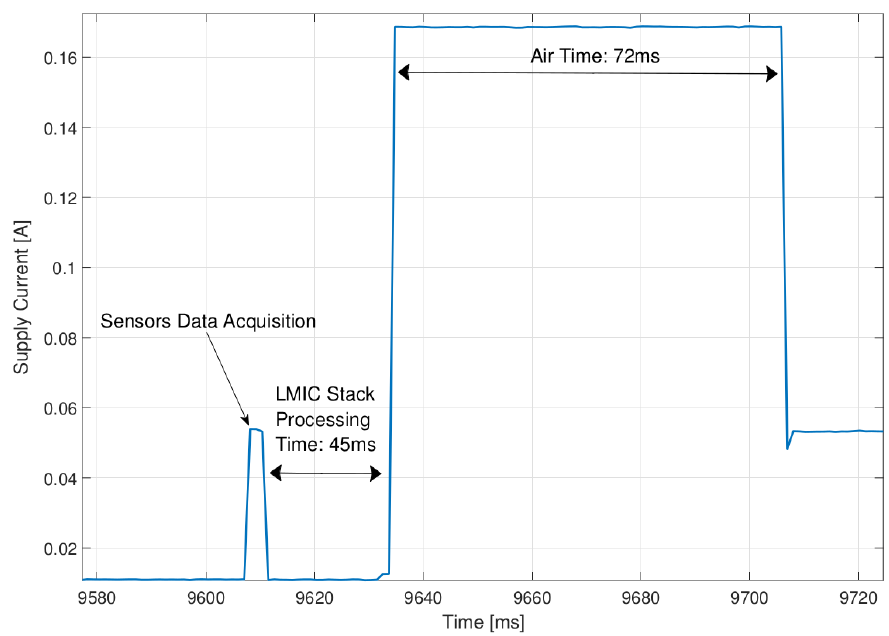
Figure 5. Sensor Node supply current at 4.2V showing sensors data acquisition followed by Lo- RaWAN message transmission.